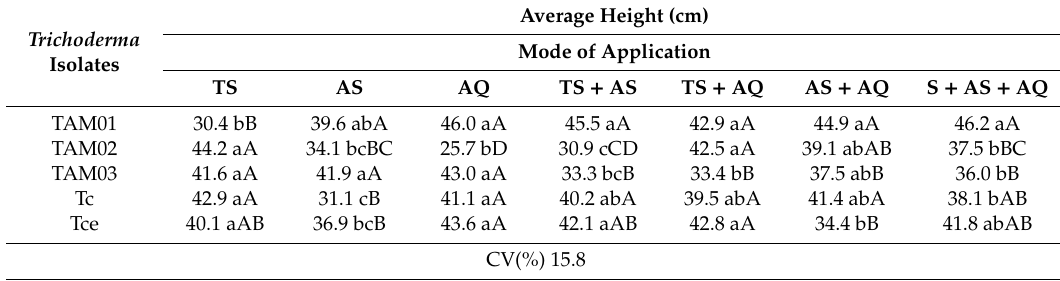
Table 4. Average height of the Aça í ( Euterpe oleracea ) plants submitted to di ff erent modes of application of five Trichoderma spp. isolates at 132 days after planting.